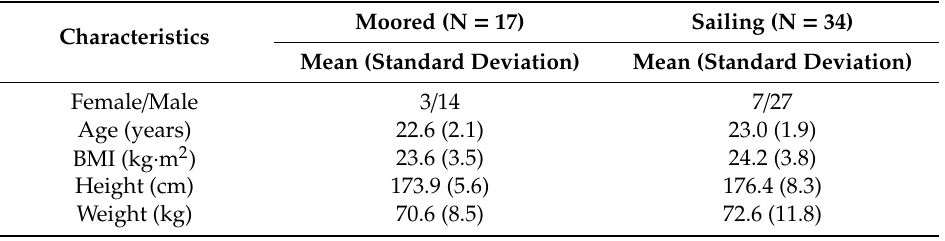
Table 1. Descriptive characteristics of participants (N =